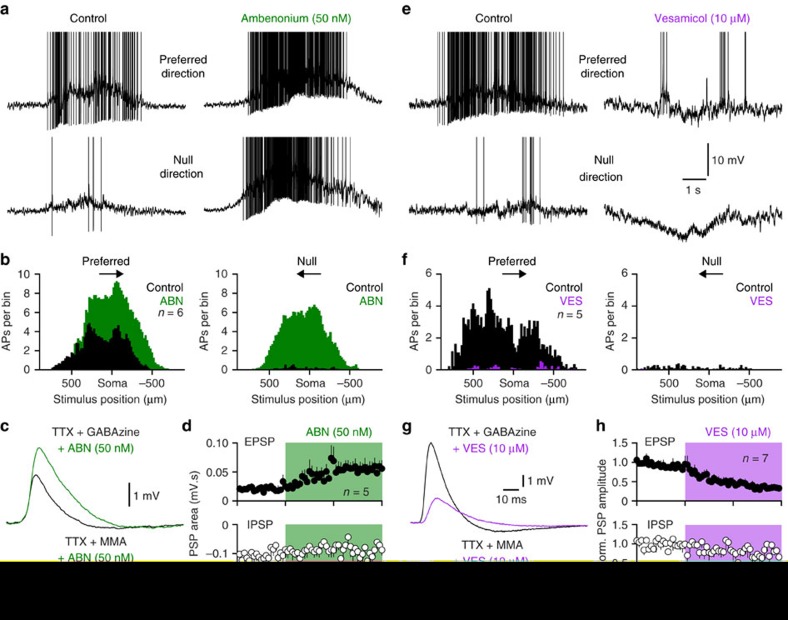
Selective pre or postsynaptic manipulation of cholinergic signalling controls light responses.(a) Blockade of acetylcholinesterase activity powerfully augments action potential (AP) firing evoked by preferred and null direction light bars (APs have been truncated for clarity). (b) Peri-stimulus histograms of light-evoked AP firing under the indicated conditions (ambenonium (ABN); bin size 20 μm). (c) Ambenonium augments pharmacologically isolated SAC-mediated excitatory PSPs (recorded in tetrodotoxin (TTX); 1 μM and GABAzine (10 μM)), but not inhibitory PSPs (recorded in TTX and mecamylamine (MMA); 10 μM). (d) Pooled data showing the selective augmentation of the area of excitatory PSPs by the blockade of acetylcholinesterase activity (area measured over a 100 ms time-window). (e) Blockade of the vesicular ACh transporter attenuates preferred direction light-evoked AP output, and unmasks null direction membrane hyperpolarization. (f) Peri-stimulus histograms of light-evoked AP firing under the indicated conditions (vesamicol (VES); bin size 20 μm). (g) Vesamicol attenuates pharmacologically isolated SAC-mediated excitatory PSPs, but not inhibitory PSPs. (h) Pooled data showing the selective reduction of excitatory PSPs by the pharmacological blockade of the vesicular ACh transporter (PSP amplitude has been normalized). All light stimuli were applied under photopic conditions. Stimulus intensity was twice that of background illumination. Data in d,h represent mean±s.e.m.